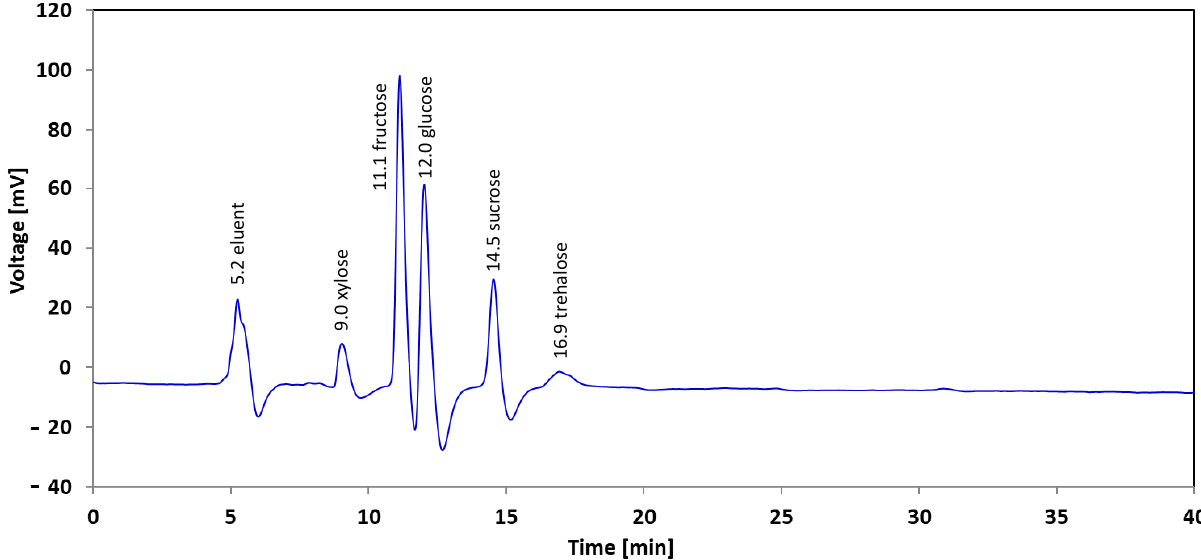
Figure 2. HPLC chromatogram of aqueous extract sugars, with ACN/H 2 O as the mobile phase at a flow rate of 0.6 mL/min and column temperature of 28 °C.